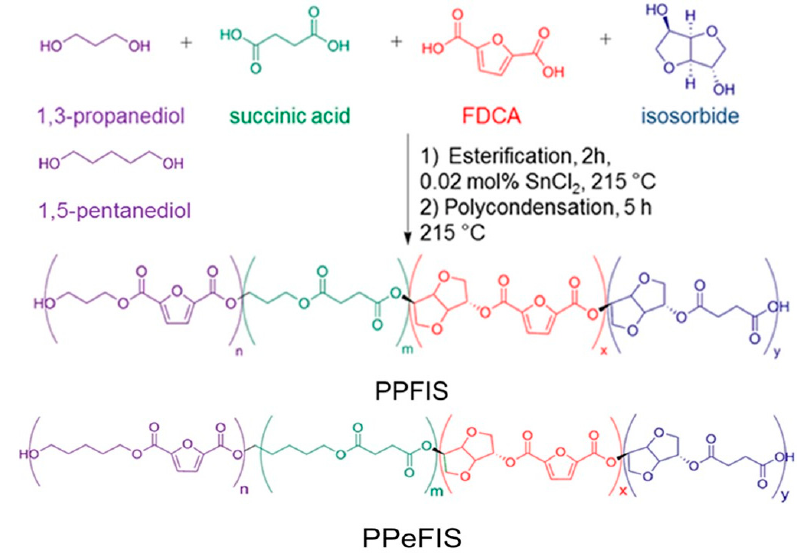
Scheme 1. Synthesis of isosorbide-based polyesters with succinic acid, furan 2,5-dicarboxylic acid (FDCA), 1,3-propanediol (PPFIS), and 1,5-pentanediol (PPeFIS). (FDCA), 1,3-propanediol (PPFIS), and 1,5-pentanediol (PPeFIS). Table 1. Synthesized biomass-derived polyesters with 1,3-propanediol and isosorbide (PPFIS) . Polymer